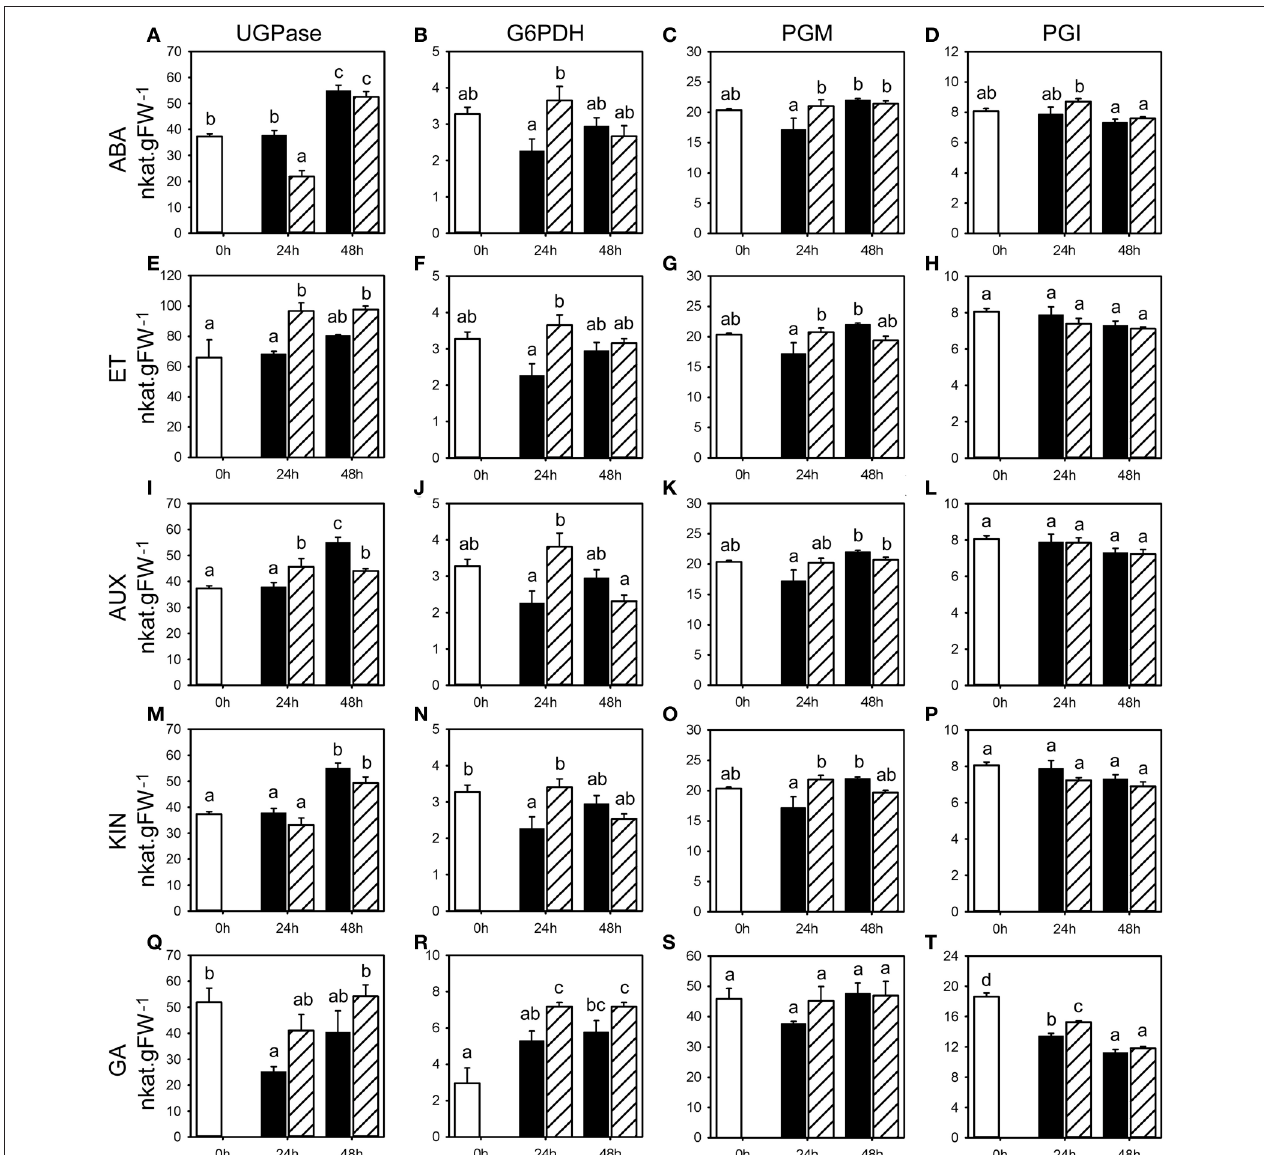
FIGURE 4 | Activities for enzymes involved in primary carbohydrate metabolism following phytohormone treatments. Enzyme activities of UGPase, G6PDH, PGM, and PGI (nkat.gFW − 1 ) in the first basal cm of stubble of 4-week old perennial ryegrass seedlings 24 or 48h post ABA (A–D) , ET (E–H) , AUX (I–L) , KIN (M–P) , or GA (Q–T) treatment, compared to untreated controls (0h). Open bars, untreated controls; closed bars, mock treatment; dashed bars, phytohormone treatment. Values represent the mean of three biological replicates ± SE. Different letters indicate statistical significance at p < 0.05 . Representative examples are shown from one of the three